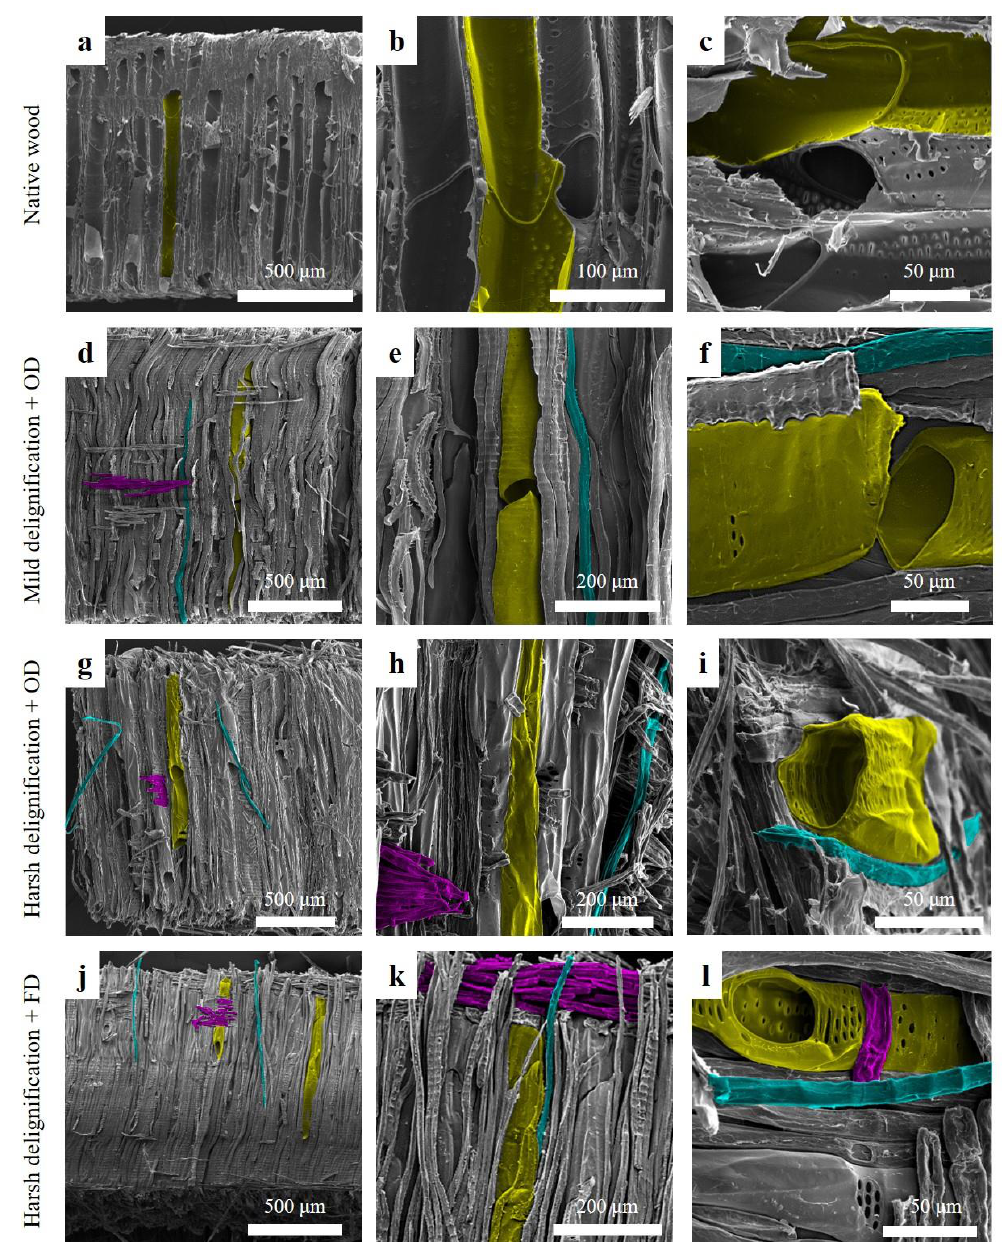
Figure 2. SEM images showing the effect of delignification on the structure of beech wood with increasing removal of lignin and various drying processes. To help visualization, wood anatomical features are highlighted in some images: vessels are inked in yellow, fibers in turquoise and ray cells in violet. ( a – c ) Native wood, ( d – f ) beech wood after mild delignification and OD; ( g – i ) beech wood after harsh delignification and OD; ( j – l ) beech wood after harsh delignification and FD. As lignin is partially removed through mild delignification (Figure 2d,f), we observed several structural changes. Fibers became more visible as they detached partially from the bulk (Figure 2e).